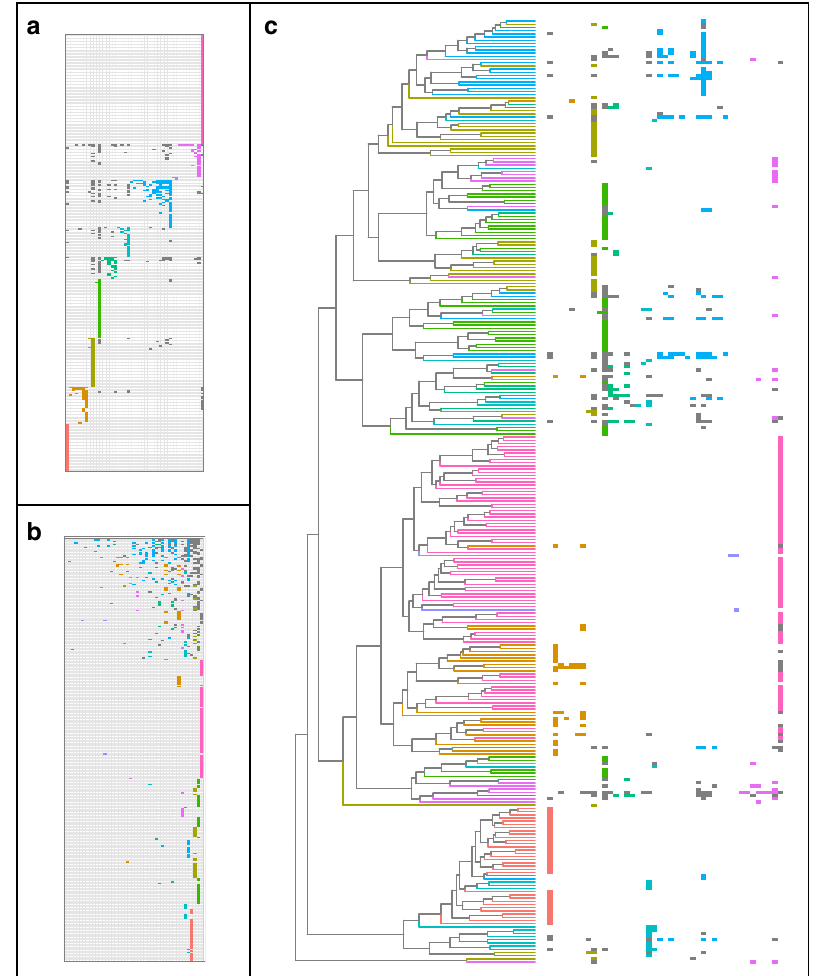
Fig. 2 Three different ways of viewing the Nymphalidae-plant network. Butter fl y genera are in rows and host plant orders are in columns. Each fi lled cell indicates a butter fl y – plant interaction and each colour shows interactions within a module (grey cells are interactions between modules). a Rows and columns sorted to emphasise modular af fi nity (order of modules is arbitrary). b Rows and columns sorted to emphasise nestedness, ordered from the upper right corner according to descending number of interactions. c Resorting of the rows of the matrix (right) to match the Nymphalidae phylogeny (left) and highlight the phylogenetic diversity in each module. Branches of the phylogeny are coloured by module af fi liation of the terminal taxa. Note that module colours are consistent with Fig. 3. For taxon names see Supplementary Figs. 5 and